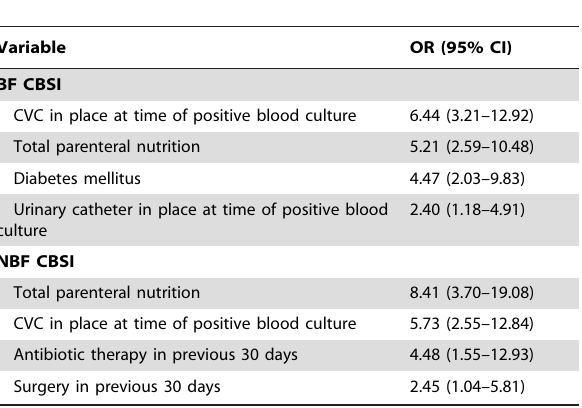
Table 2. Logistic regression analysis of risk factors for candidemias by biofilm-forming (BF) and non-biofilm-forming (NBF)